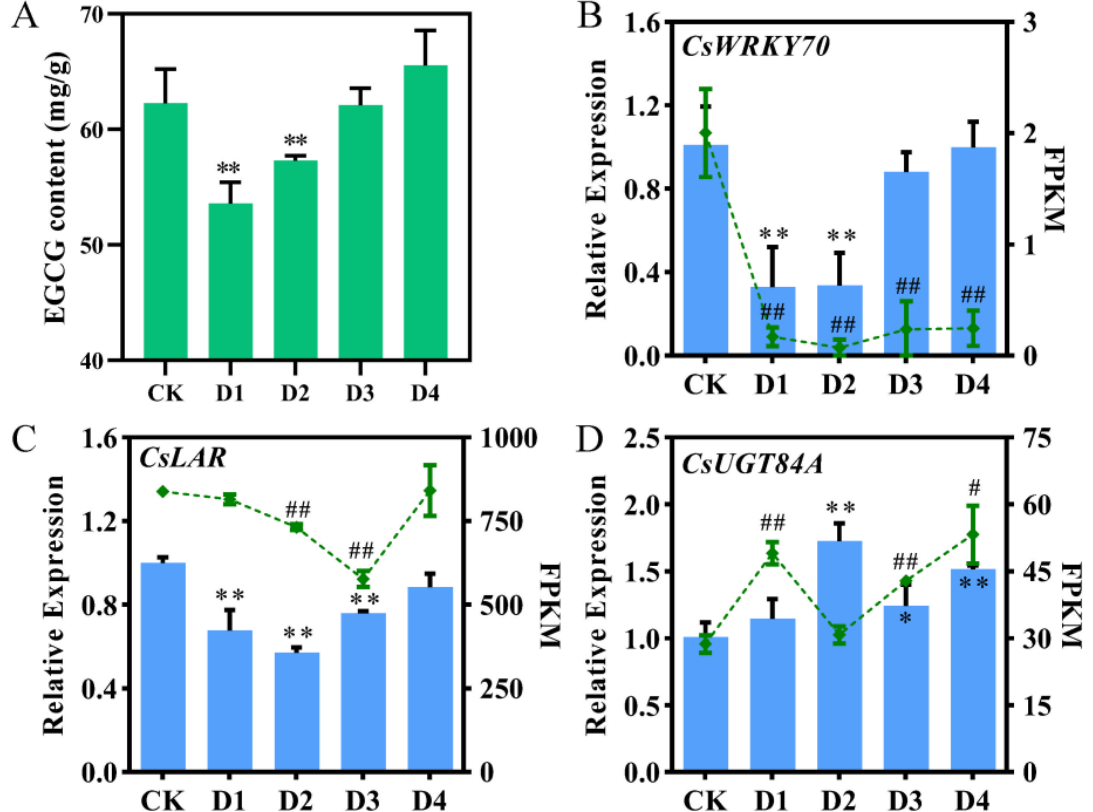
Figure 1. EGCG content and expression levels of CsWRKY70, CsLAR , and CsUGT84A from qRT-PCR and RNA-seq. ( A ) EGCG content in tea leaves after foliar application of different concentrations of nano-Se. ( B – D ) Expression levels of CsWRKY70, CsLAR , and CsUGT84A from qRT-PCR (bar graphs) and RNA-seq (line graphs). FPKM represents fragments per kilobase of transcript per million mapped reads. * and ** represent significant differences ( p < 0.05 and p < 0.01, respectively) compared to control in qRT-PCR data. # and ## represent significant differences ( p < 0.05 and p < 0.01, respectively) compared to control in RNA-seq data. Data were analyzed by one-way